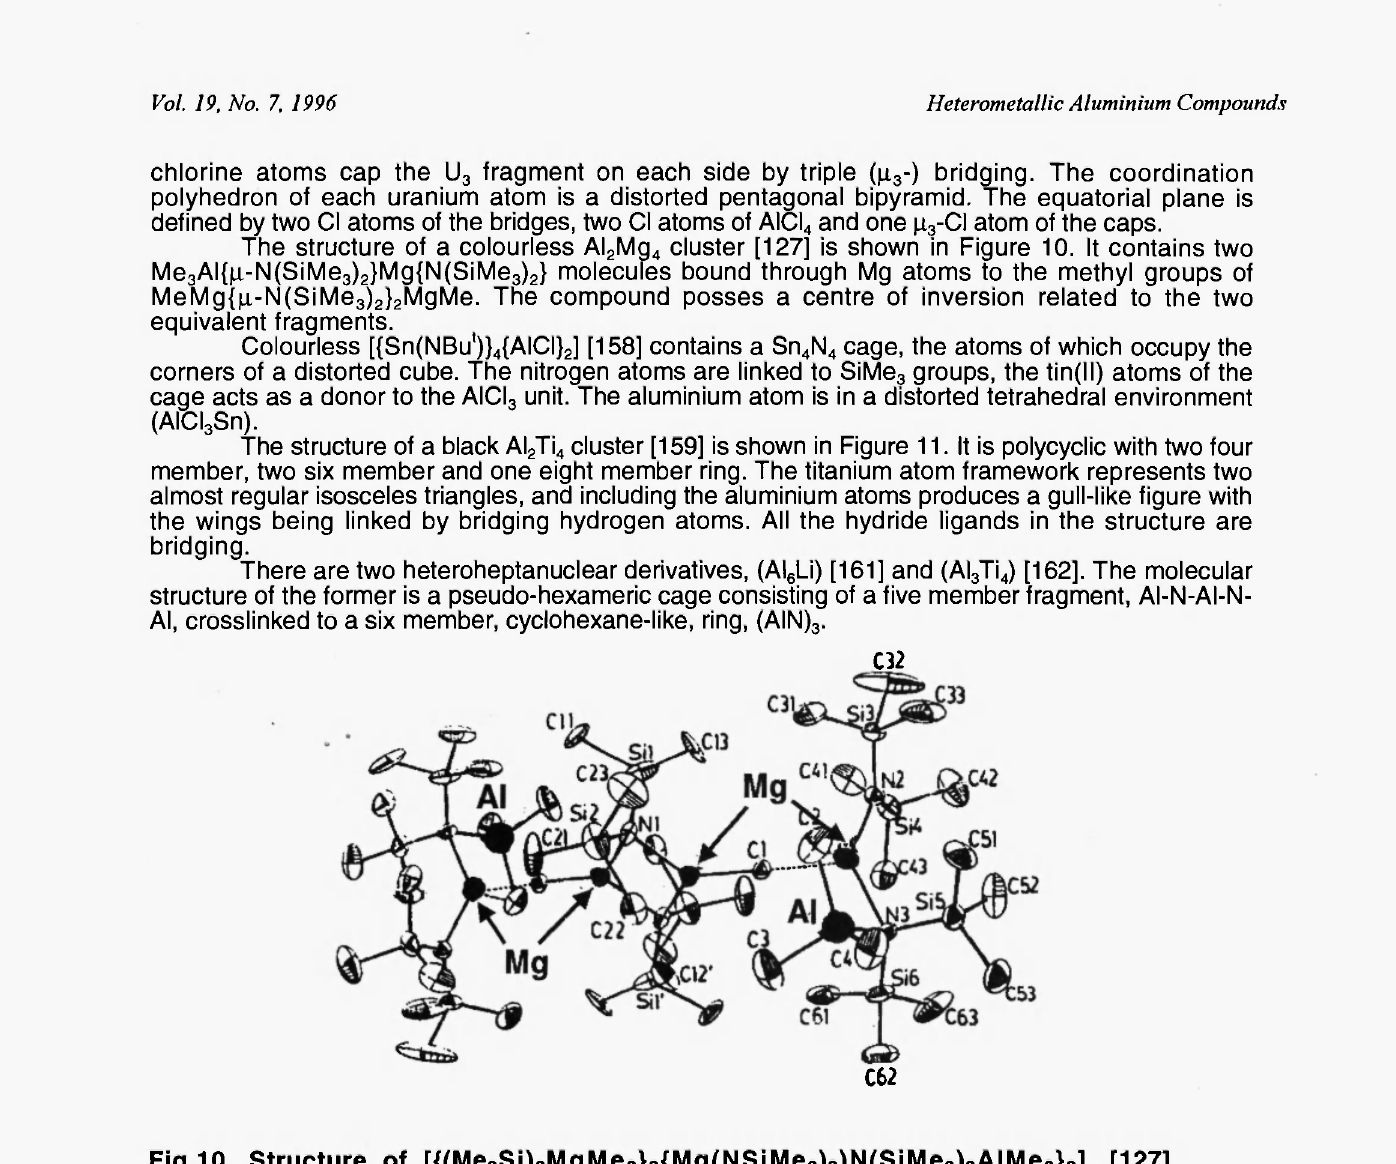
MgMe2}2{Mg(NSiMe3) 2